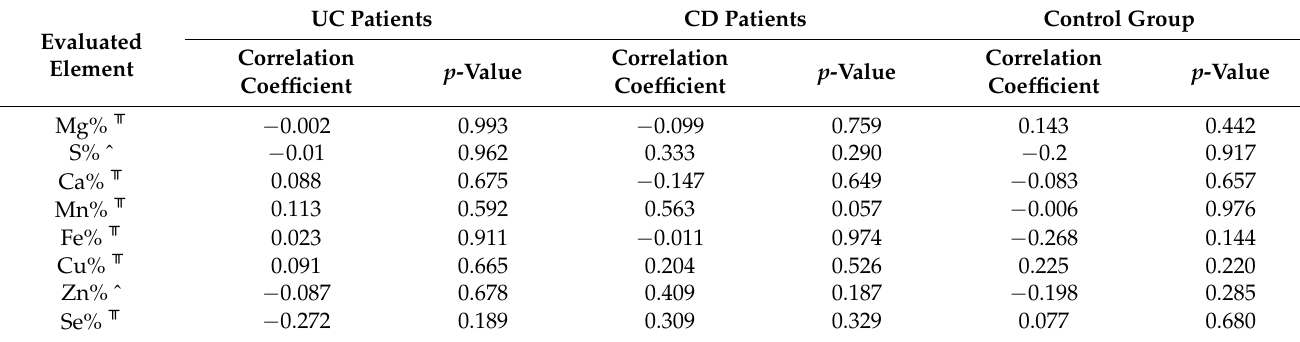
0.319 The correlations evaluated between the markers of systemic inflammation and active disease (CRP, CRP/albumin, fibrinogen, neutrophil-to-lymphocyte ration and fibrinogen) and mineral and trace elements concentration in hair did not reach the level of statistical significance (Table 3). Table 3. Evaluating the correlation between hair micronutrient concentration and inflammatory markers for IBD patients. Evaluated Ele- ment